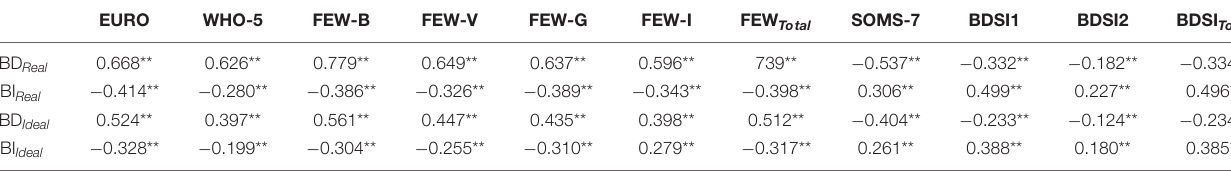
TABLE 5 | Associations of the real and ideal version of the FKB-6 with related measures. EURO WHO-5 FEW-B FEW-V FEW-G